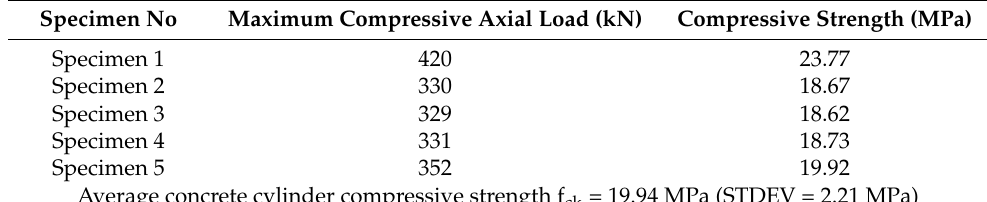
Table 1. Results of concrete cylinders tested in uni-axial compression. The specimens’ diameter = 150 mm, height = 300 mm.